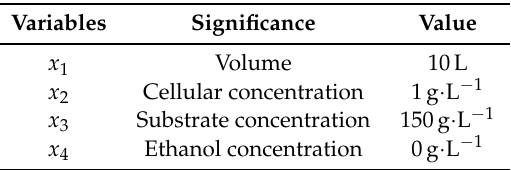
Table 5. Initial values employed for the in silico ethanol production process